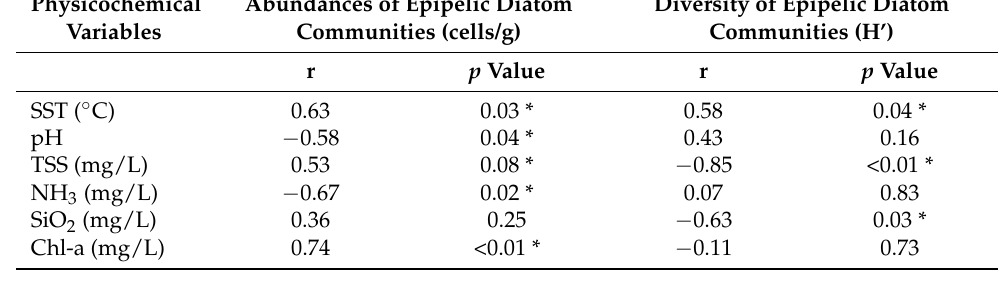
Table 2. Pearson’s correlation coefficient (r and p value) of epipelic diatom abundance (cells/g) and diversity (H’) against significant physicochemical variables at Port Dickson co ast. Asterisk (*) indi- cates significance at 0.05 level (2-tailed). Parameters with no significant correlations were excluded.